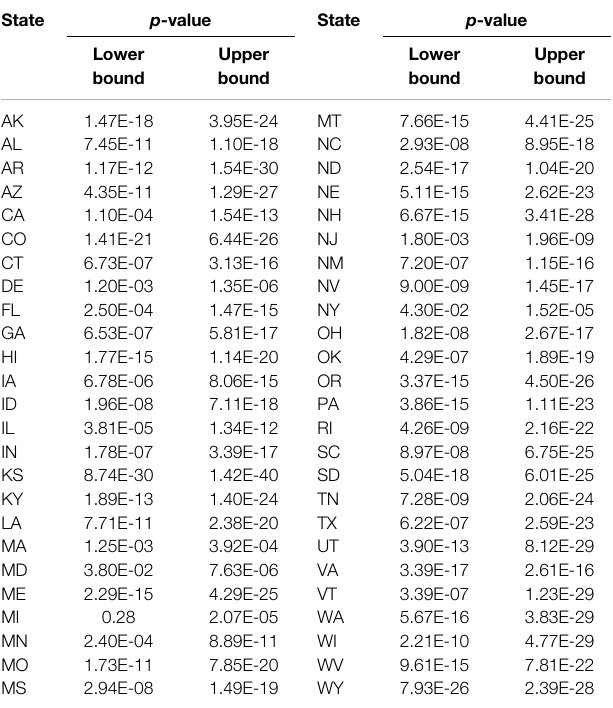
TABLE 3 | Ranges of p -values for testing 18 temporal potential causes of the number of new deaths from COVID-19 across 50 states in the US.